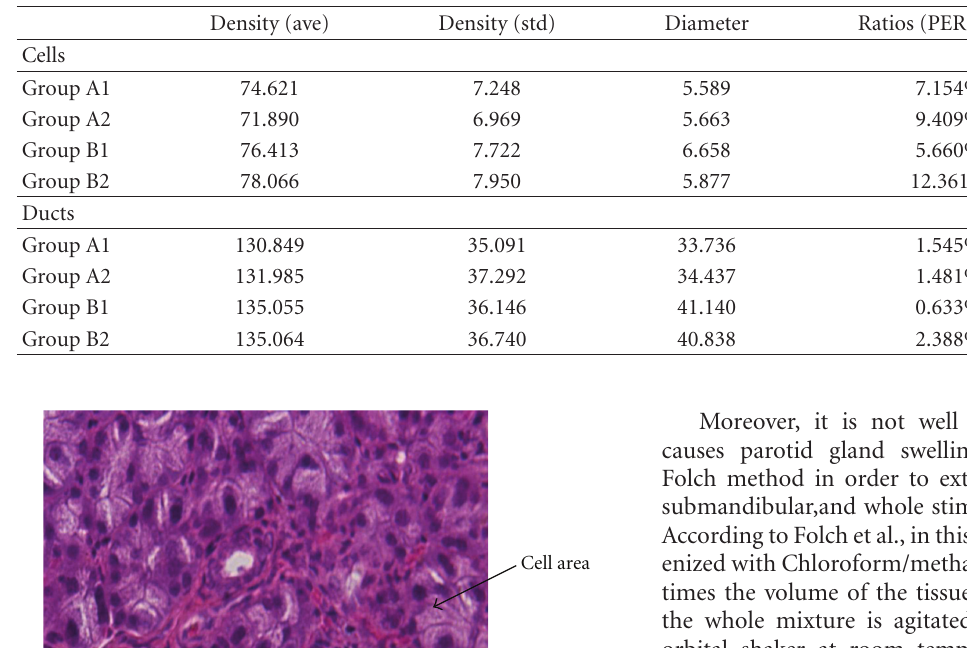
Table 2: Item Measurement parameters (statistical average value) for cells and ducts in the four groups of animals.